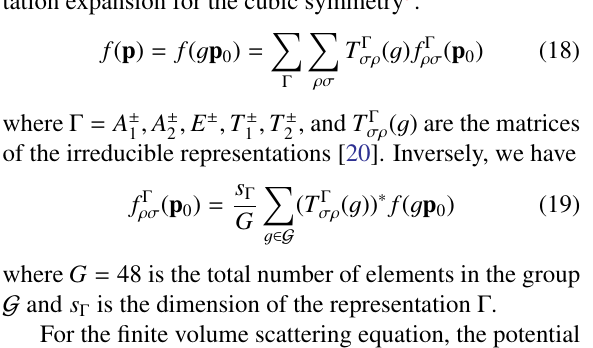
tation expansion for the cubic symmetry 5